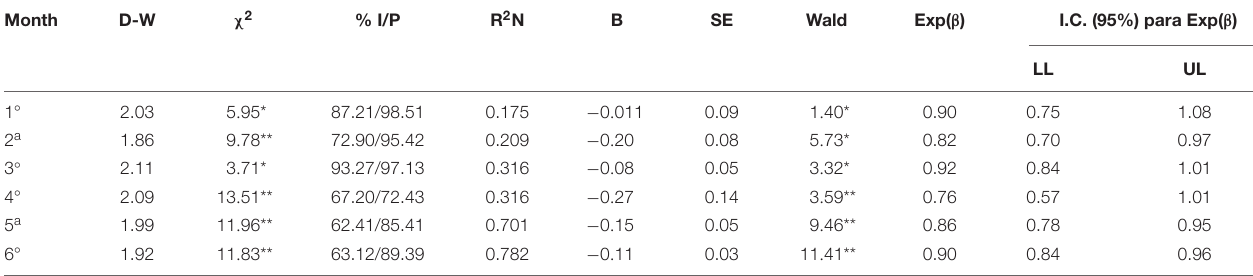
TABLE 6 | Predictive model of the SRSA-18 for 6-month follow-up period. Month